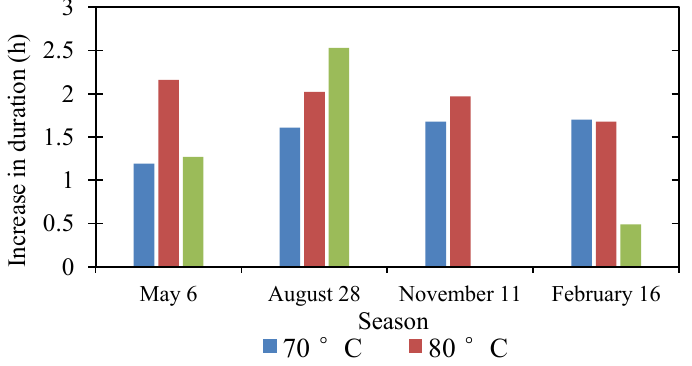
Figure 12. Summary of the increase in duration of usable temperatures with the proposed CPC by season and required